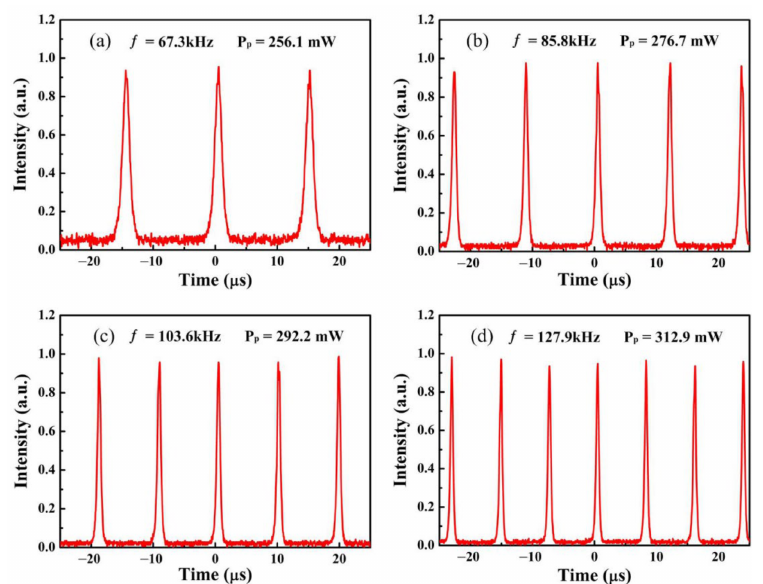
Figure 23. Passive Q-switching pulse trains of orange-light Pr 3+ -doped all-fiber laser based on WS 2 SA under different incident pump powers of P p . ( a ) P p = 256.1 mW, ( b ) P p = 276.7 mW, ( c ) P p = 292.2 mW and ( d ) P p = 312.9 mW. Reprinted with permission from